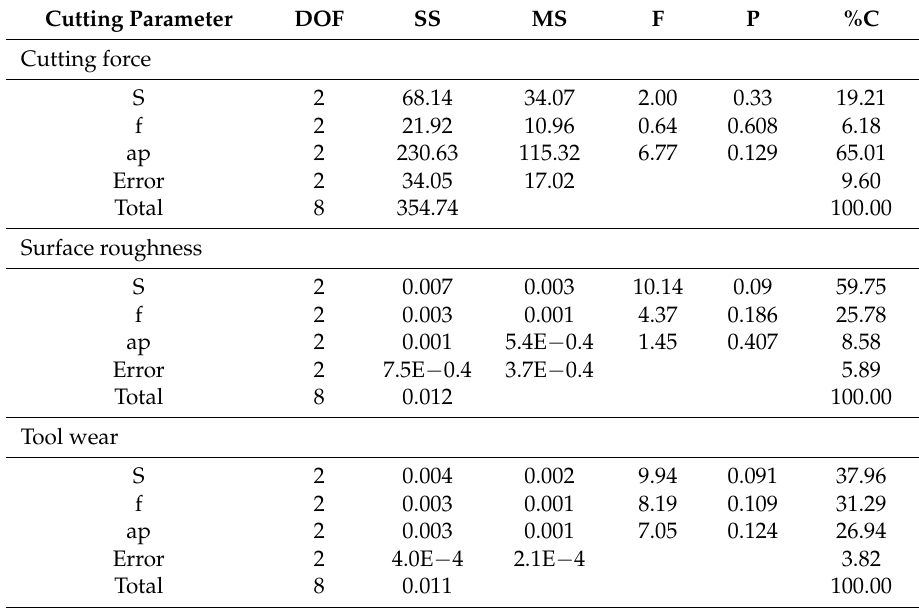
Table 8. The results of the ANOVA for cutting force, surface roughness, and tool wear on the coated tool. Cutting Parameter